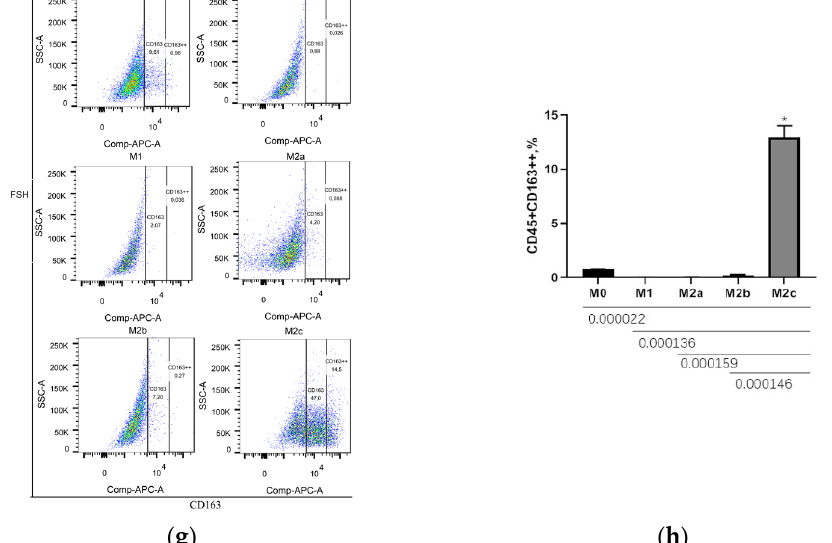
Figure 2. CD206++ and CD163++ are the markers of M2a and M2c macrophages, respectively. Monocytes from healthy donors were cultured in medium with 10% human sera for three days, to differentiate into M0. M1, M2a, M2b, and M2c macrophages were then generated by being stimulated with LPS and IFNr, IL-4, LPS and IL-1b, and IL-10, respectively, for 48 h. Population frequencies of M1 conditioned cells were assessed with two marker sets: CD45 and CD80 ( a , b ). Population frequencies of M2a-, M2b- and M2c-conditioned cells were assessed with two marker sets: CD45 and CD206 ( c , d ), CD45 and LIGHT ( e , f ), CD45 and CD163 ( g , h ), respectively. ( a , c , e , g ) are representative flow cytometric plots of the mixture of 2 out of 10 donors. Bar graphs ( b , d , f , h ) represent the mean and SD of population frequencies of CD45+CD80++, CD45+CD206++, CD45+LIGHT+, and CD45+CD163++, respectively, for at least ten different individual subjects. Statistical significance was calculated using nonparametric one-way ANOVA. * Represents p < 0.05. Table 1. Population frequencies of human uncommitted, M1, M2a, M2b, and M2c.